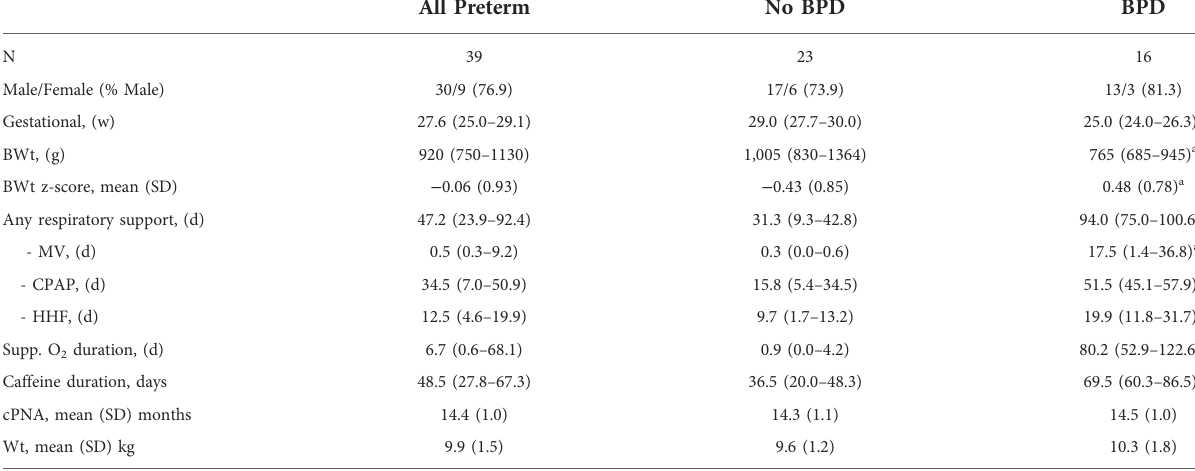
TABLE 1 Describing the study population of preterm born infants, and by neonatal classi fi cation of bronchopulmonary dysplasia (BPD). All